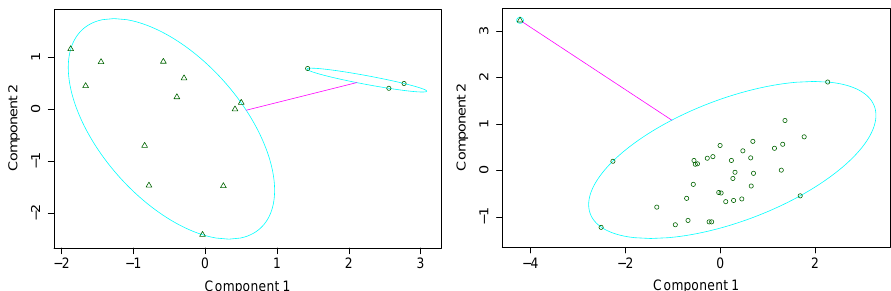
Figure 12. Same as Figure 10. The left panel shows PAM clustering with the three parameters being τ lag,i , t radio,pk,i , and Age, while the outliers are GRBs 010921A, 031203A, and 050416A. The right panel shows PAM clustering with the three parameters being τ lag,i , N H , and α Band , while the outlier is GRB 080319B.